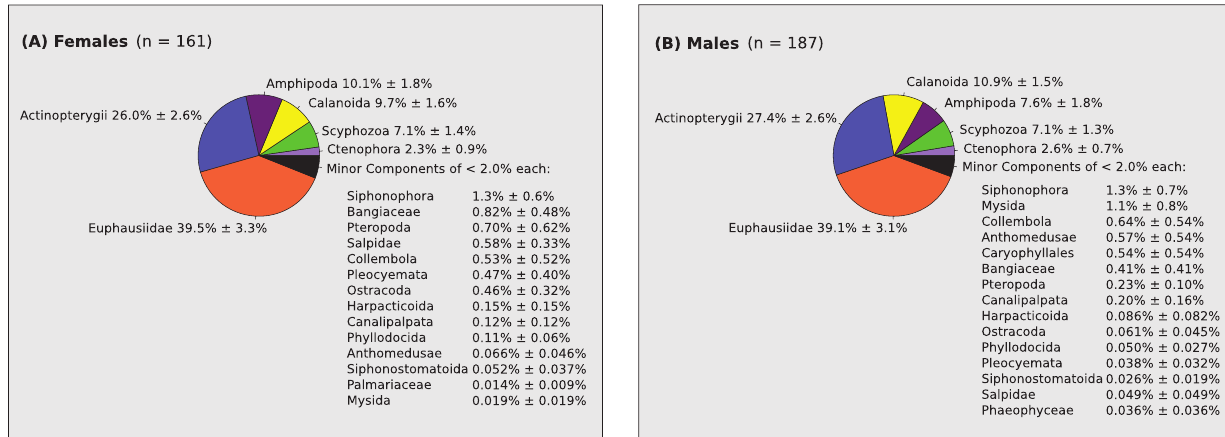
Figure 3. Female and male Ade´lie penguin diet. A comparison of male and female diet for all samples in this study that produced recognisable food DNA sequences and which had a successful molecular sexing assay result. The pie charts show the estimated mean and standard error of the proportions of DNA sequences from each food group for females (A) and males (B).